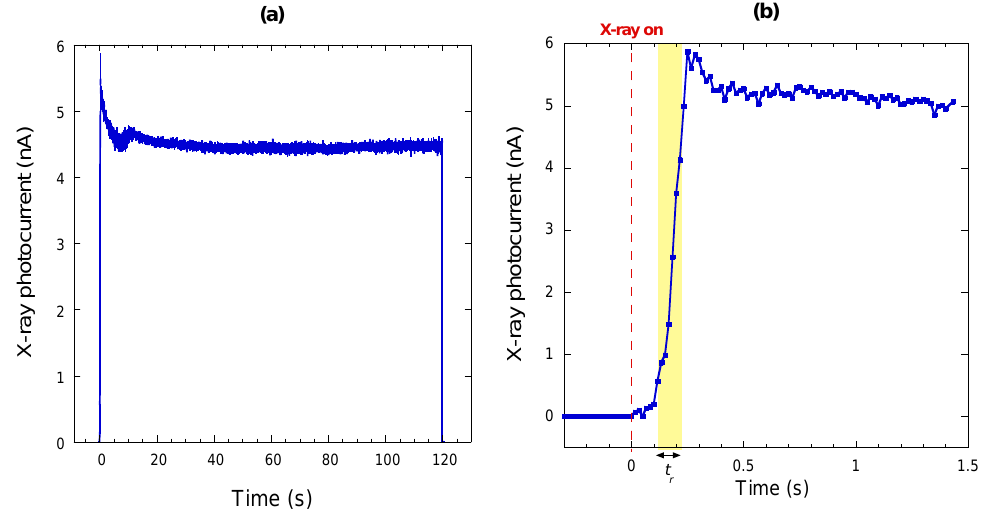
Figure 5. ( a ) X-ray photocurrent signal acquired at a fixed DR of 1 Gy/min. The total acquisition time (120 s) corresponds to the acquisition of 7200 X-ray pulses; ( b ) Zoomed image of the X-ray photocurrent signal soon after the X-rays are switched on. Yellow box extends from 10% to 90% of the final photocurrent value to highlight the rise time t r .